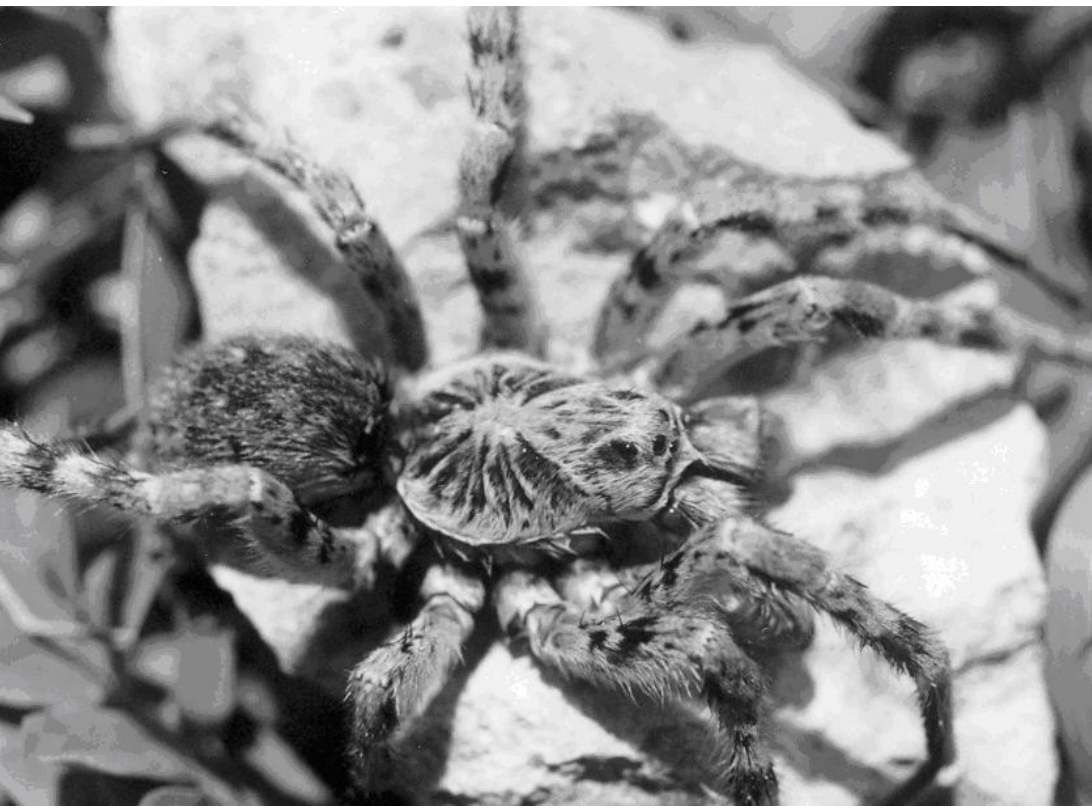
L. singoriensis venom apparatus has the same general structure of those from other spiders, it is situated in the anterior part of the prosoma and composed of a pair of venom glands, a pair of chelicerae with apical fangs and a pair of canals (or ducts) that connect the glands through the chelicerae to the tip of the fangs. Like in other ground-living and burrowing spiders, the chelicerae consist of two parts: basal segment (paturon) and a movable articulated apical segment (fang). The basal segments of the chelicerae are very stout and strong, and are covered by hair, similarly to the rest of the body (Figure